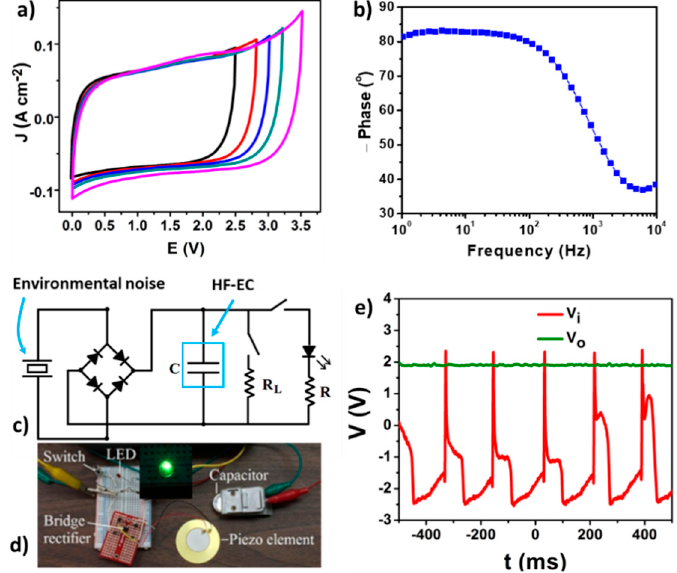
Figure 7. ( a ) CV profiles within different potential windows at scan rate of 100 Vs − 1 and ( b ) Bode plot for the organic cell. ( c ) The diagram and ( d ) photo of the circuit used for pulse energy scavenge and storage. ( e ) The scavenged pulse V i (red curve) and the DC output V o (green curve) after being filtered by the HF-EC to a micro-power load. Reproduced with permission from Ref. [13] Copyright 2017, Elsevier. 356